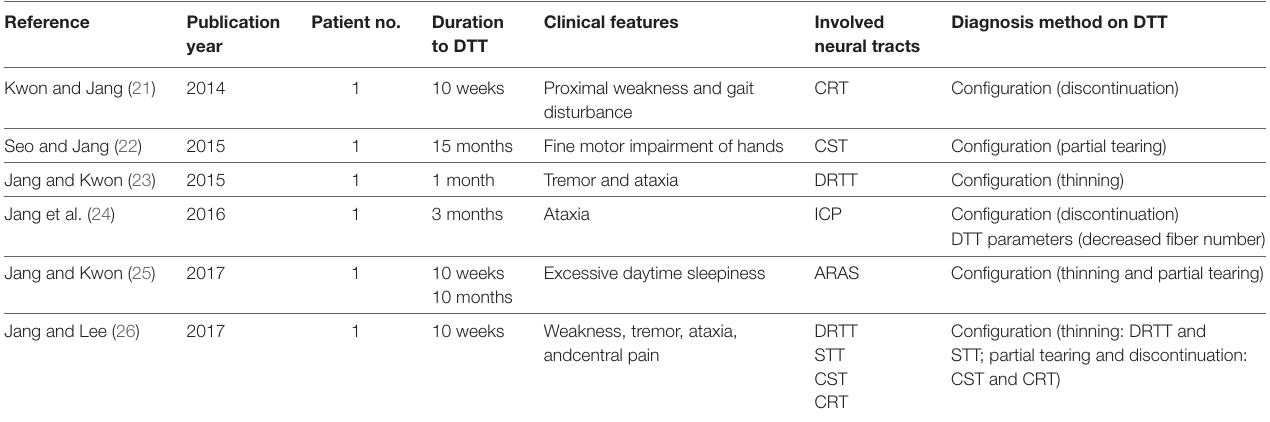
TABle 1 | DTT studies on traumatic axonal injury in patients with whiplash